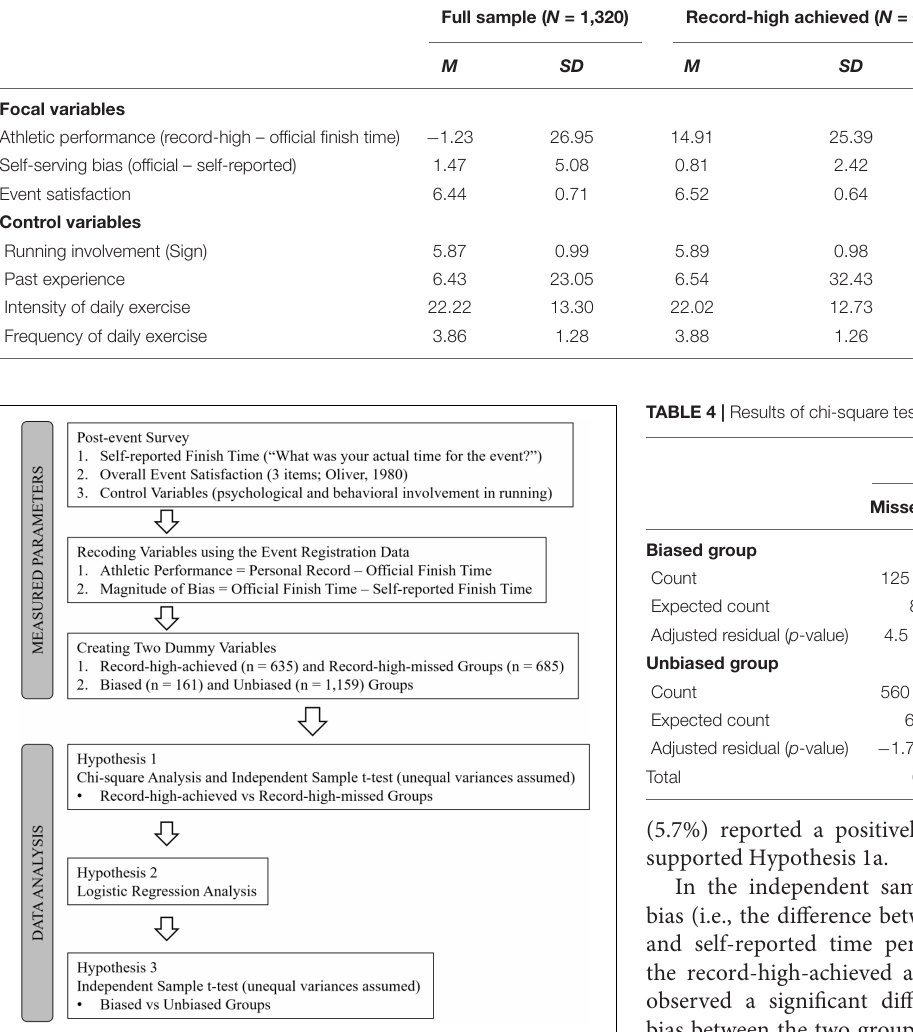
FIGURE 1 | Flow chart for the testing process and measured parameters.